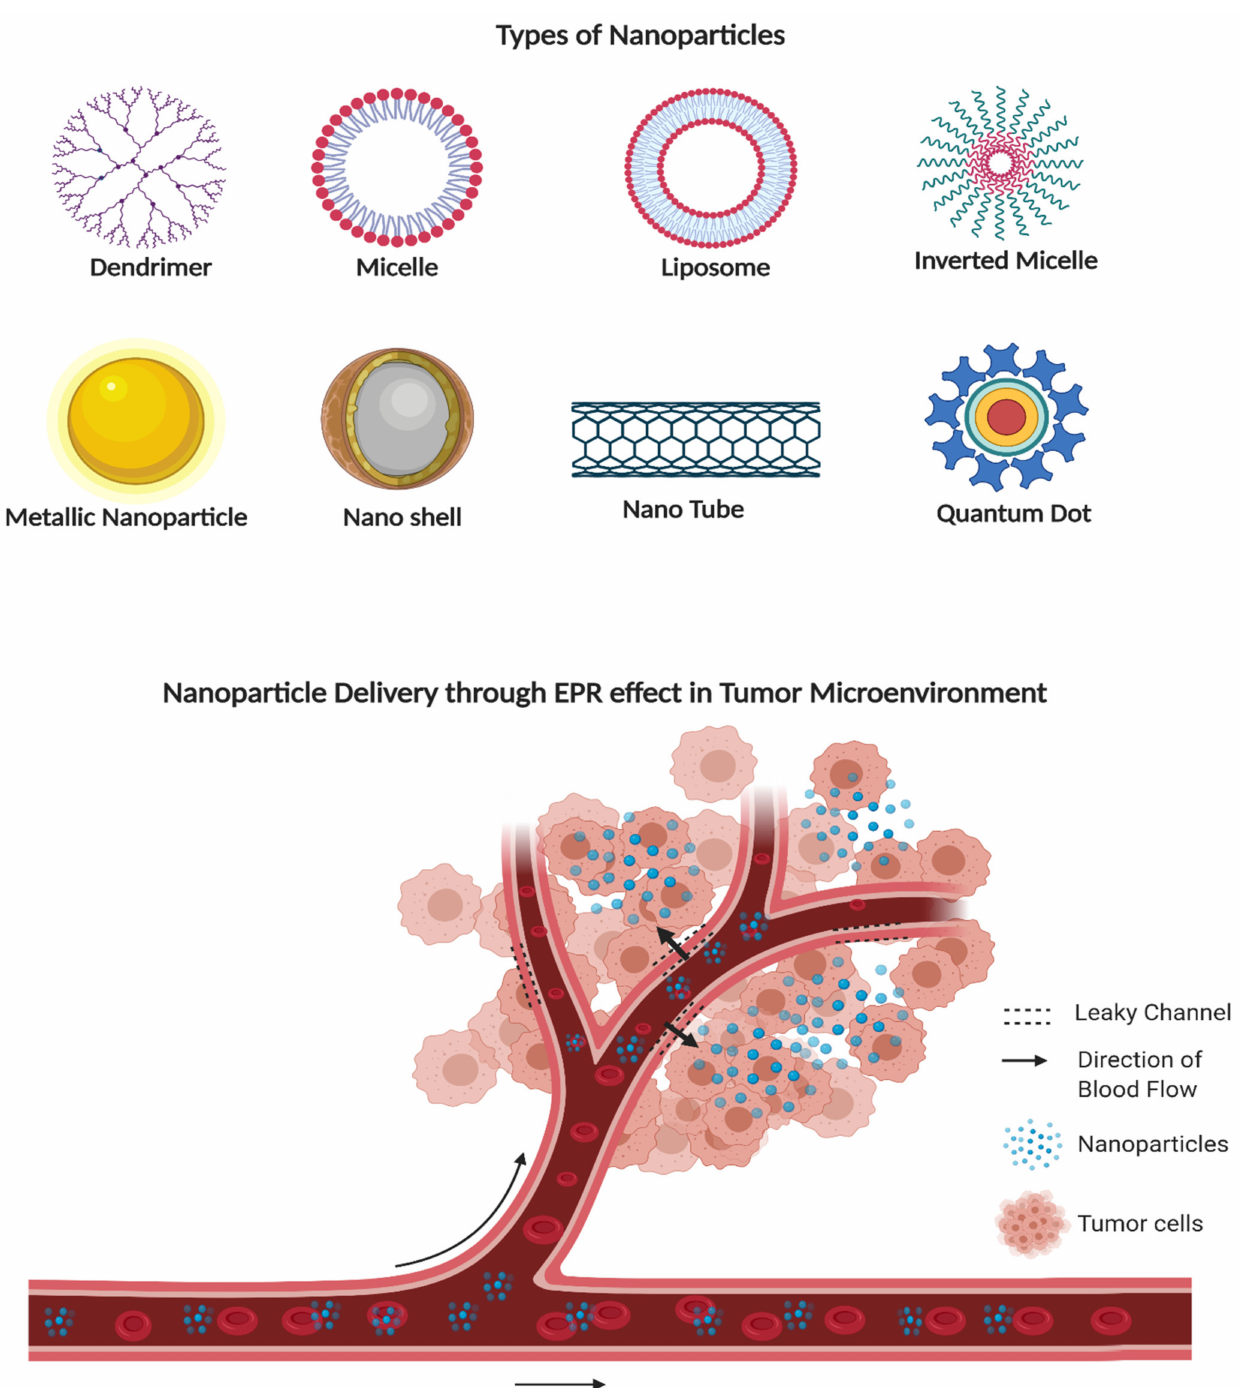
Figure 1. Types of nanoparticles and the enhanced permeability and retention (EPR) effect: top, nanoparticles that are commonly used in anti-cancer treatment; bottom, tumor vasculature and dysfunctional lymphatic drainage allows the accumulation of nanoparticles in the tumor cell environment. (Created with BioRender.com at 6 March